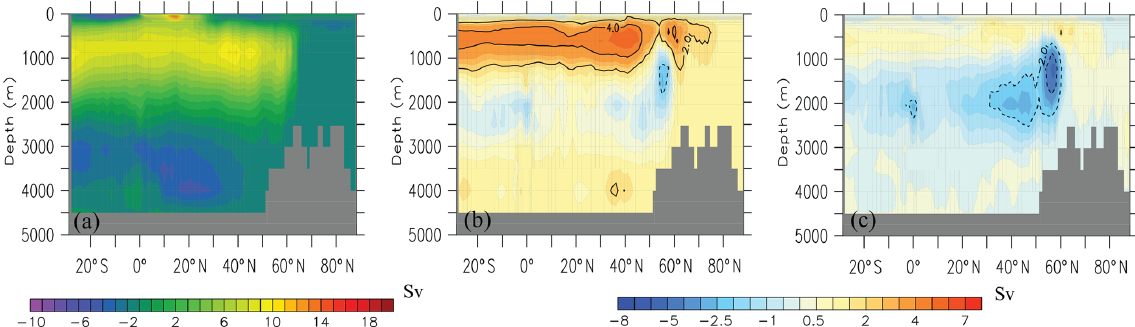
Figure 5. Mean annual AMOC of PI control (a) and AMOC anomalies of Eoi400 (b) and PlioMIP 1 (c) in comparison with PI